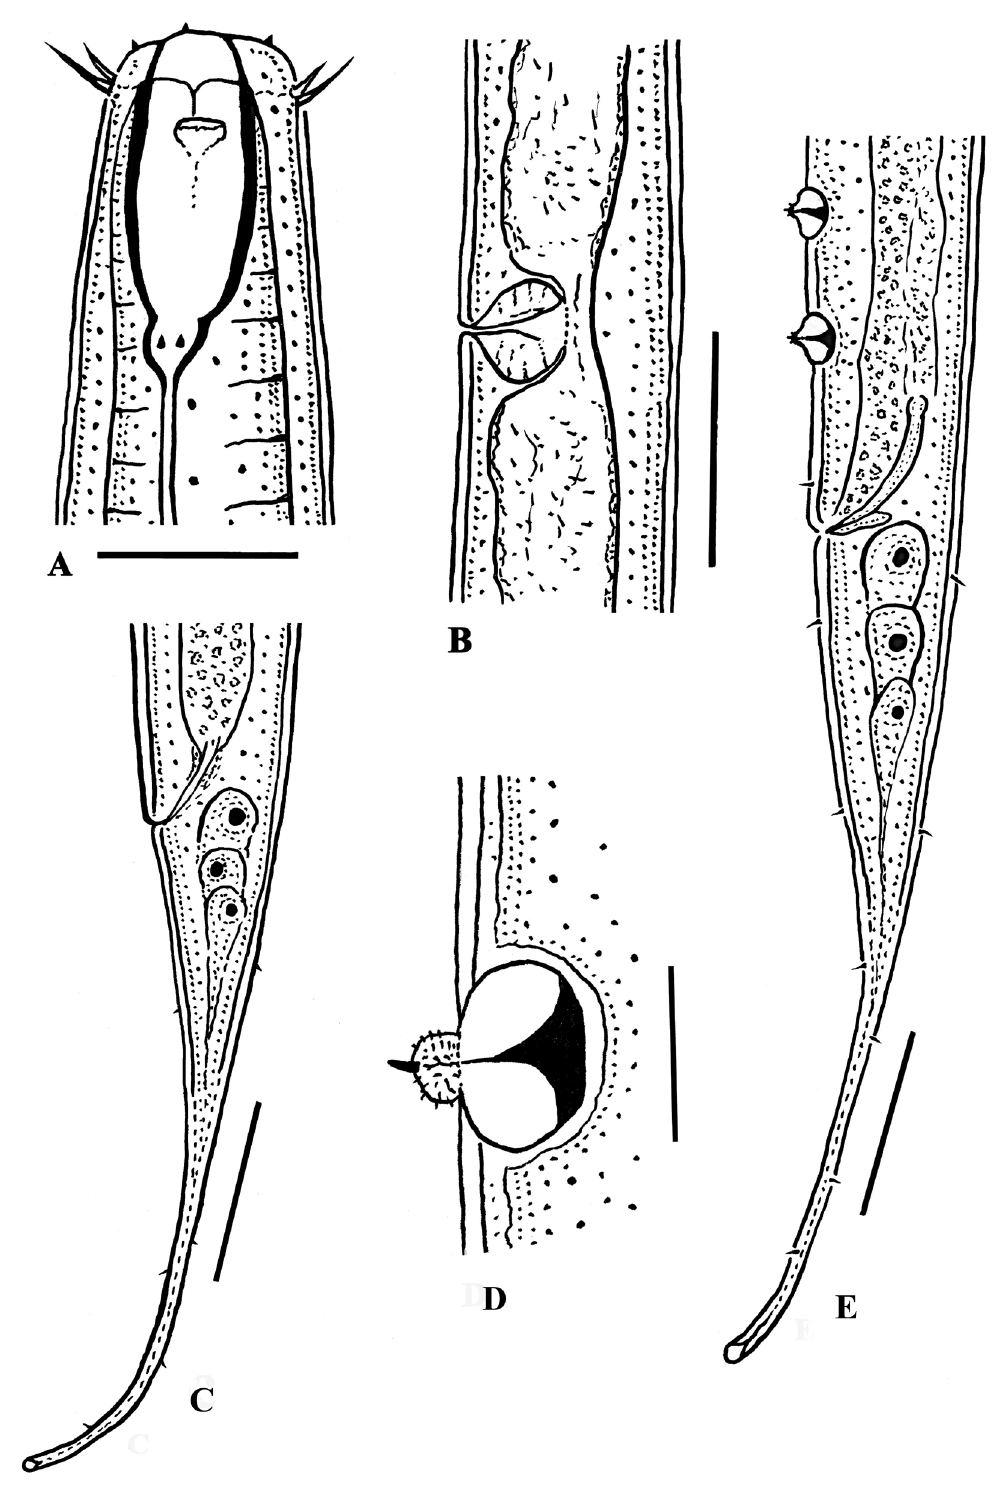
Fig. 3. Paratrilobus aquaticus sp. nov. A . Male anterior end. B . Female vulva region. C . Female posterior body end. D . Male precloacal supplement. E . Male posterior body end. A, D–E: holotype (HM RAS 102/64 768-2); B–C: paratype (HM RAS 102/64 768-4). Scale bars: A = 30 µm; B = 70 µm; C = 60 µm; D = 20 µm; E = 50